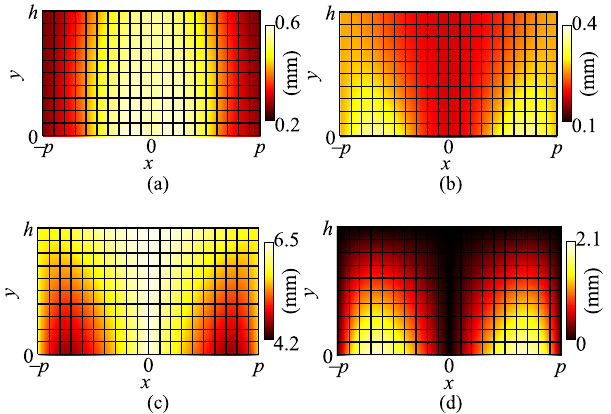
Fig. 17. Physical dimensions of the anisotropic unit cell elements for the implementation of the groove illusion medium. (a) Line width W x . (b) Line width W y . (c) Line length l x = l y = l . (d) Line length l M .